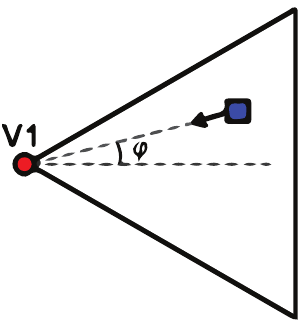
Figure 7. Monitoring model considering the angle of